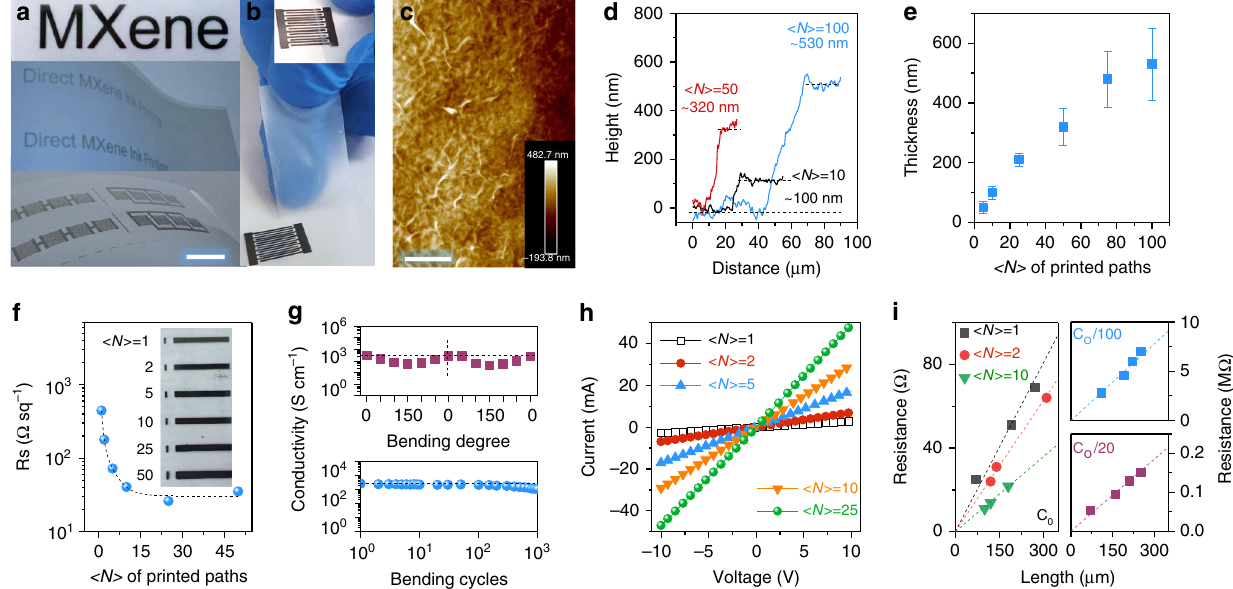
Fig. 3 Inkjet printing of MXene organic inks. a Optical images of inkjet-printed “ MXene ” word (top), “ Direct MXene Ink Printing ” word (middle) and MSCs (bottom) supported on AlO x -coated PET. A total of 20 MSCs with different combinations and 80 letters were printed as a demonstration, indicating a high reproducibility of the inkjet printing. Scale bar = 1 cm. b Multiple peeling tests of an inkjet-printed MSC (inset) using scotch tape. No material is stuck to the tape after ten peels, indicating a strong adhesion between the printed lines and the AlO x -coated PET substrate. c AFM image of the inkjet-printed line, showing a homogenous surface consisting of interconnected nanosheets. Scale bar = 10 µ m. d The height pro fi les of inkjet-printed lines with different number of paths, < N >. e The line thickness plotted as a function of < N >. The lines in ( d ) and ( e ) were printed using NMP ink with a concentration of 12.5 mg mL − 1 . f The sheet resistance, R s , plotted as a function of < N >. Inset shows the optical images of various printed lines (2 cm in length) with different < N >. g The electronic conductivity changes as a function of bending degree (top) and number of bending cycles (bottom). One cycle is de fi ned as bending the printed line to 150° then releasing to 0° ( fl at). h I – V curves of lines with different < N >. i Resistance of the printed lines with different < N > plotted as a function of length (left). An excellent linearity is observed in all the as-printed lines. The right panel shows resistance of lines with < N > = 1 using NMP ink, indicating a line resistivity of 620 k Ω µ m − 1 and 26 M Ω µ m − 1 achieved in the inks diluted by 20 times (~0.63mg mL − 1 , bottom right) and 100 times (~0.13 mg mL − 1 , top right),